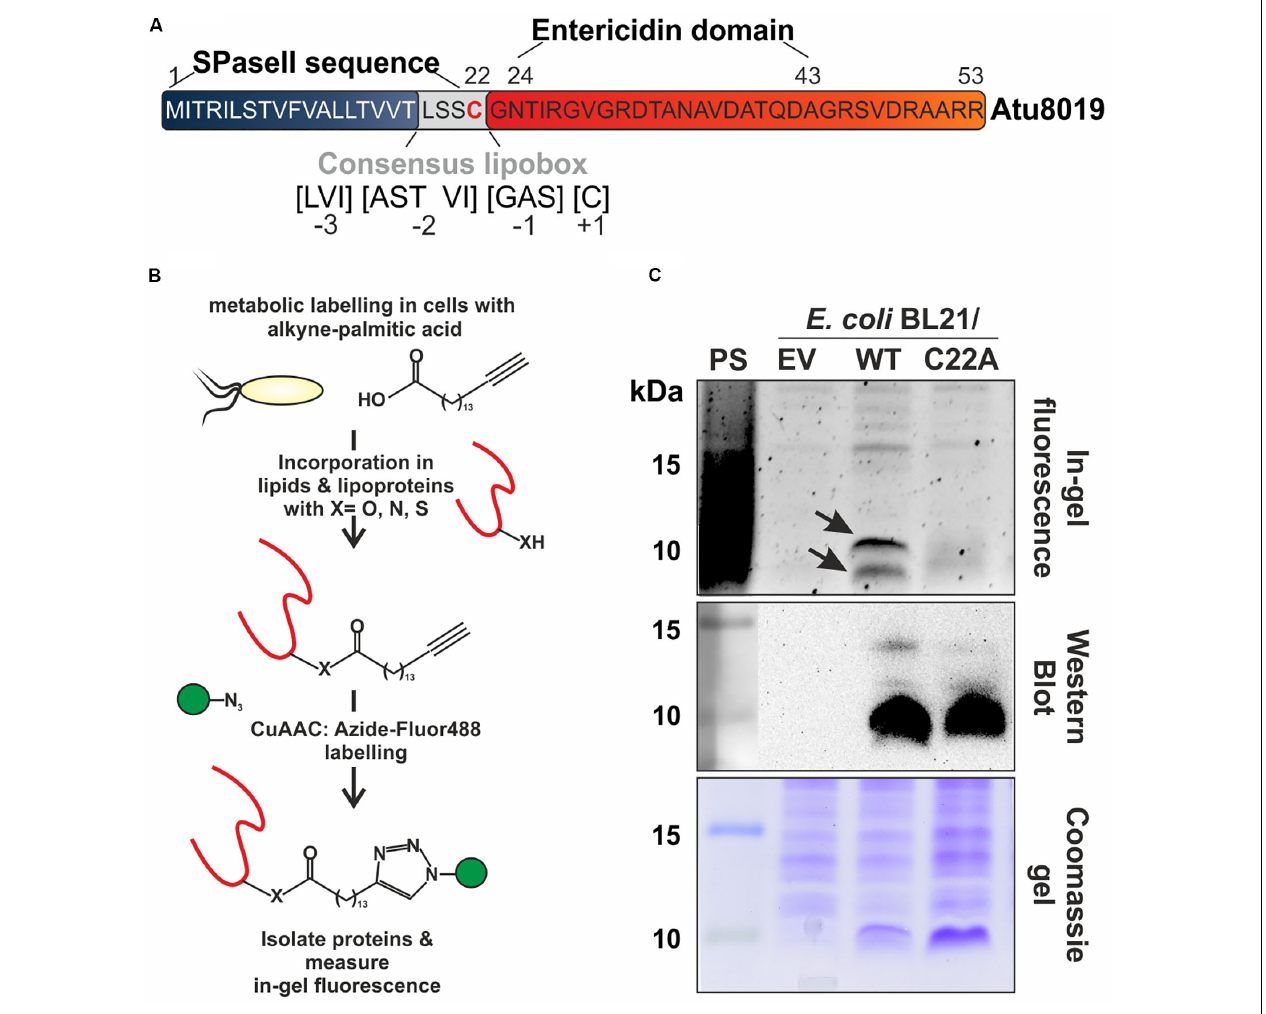
FIGURE 2 | Experimental validation of Atu8019 lipidation. (A) Atu8019 protein sequence and predicted motifs/domains. (B) Schematic illustration of the lipoprotein labeling approach. (C) E. coli BL21 expression cultures containing the pET24 empty vector (EV) or producing one of the Atu8019 HIS derivatives (WT or C22A) were grown over night with alkyne-palmitic acid. After labeling, cells were harvested, lysed, and a copper (I)-catalyzed azide-alkyne cycloaddition (CuAAC)-reaction with Azide-Fluor488 (AF488) was performed for in-gel fluorescence profiling of lipoproteins (top). The arrows indicate acylated Atu8019 protein before and after signal-peptidase II cleavage. Atu8019 HIS production was verified by Western blot (middle) and the coomassie blue-stained gel served as loading control (bottom). PS, protein